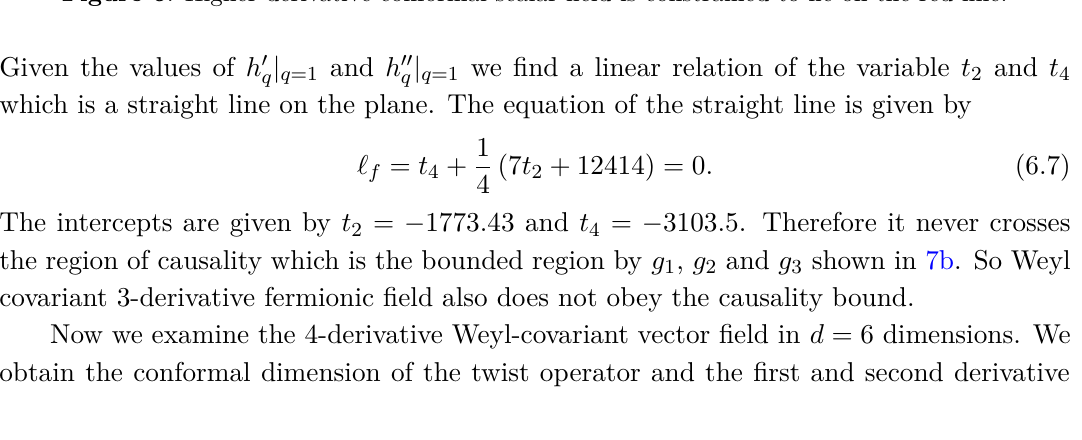
Figure 6 . Higher derivative conformal scalar field is constrained to lie on the red